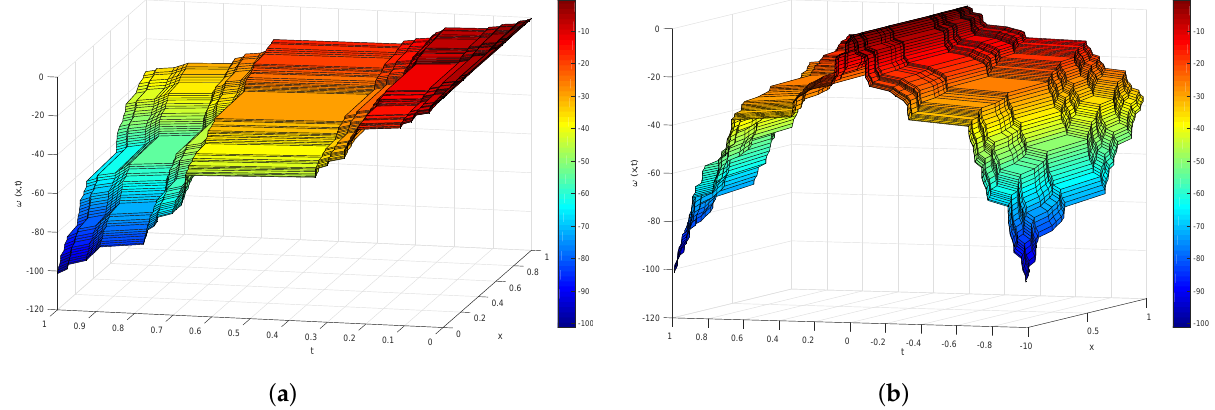
Figure 2. In the case of ω ( x , t ) solution in the local fractional sine-Gordon equations, by choosing A = 1, k = 1, c = 1, δ = 1. ( a ) 0 ≤ t ≤ 1; ( b ) − 1 ≤ t ≤ 1. The time-dependent behavior of ψ ( x , t ) and ω ( x , t ) obtained from the theory of the local number order homotopy perturbation method is shown in Figure 3. We show the elastic interaction between two solitons. It can be seen that both solitons maintain their initial velocity and shape after interaction. In Figure 4, we compare the local motion diagram of the sine-Gordon equation with integer order and fractal dimension ε = ln 2/ ln 3. Compared with the general homotopy perturbation method, the behavior graph obtained by this method is more realistic.